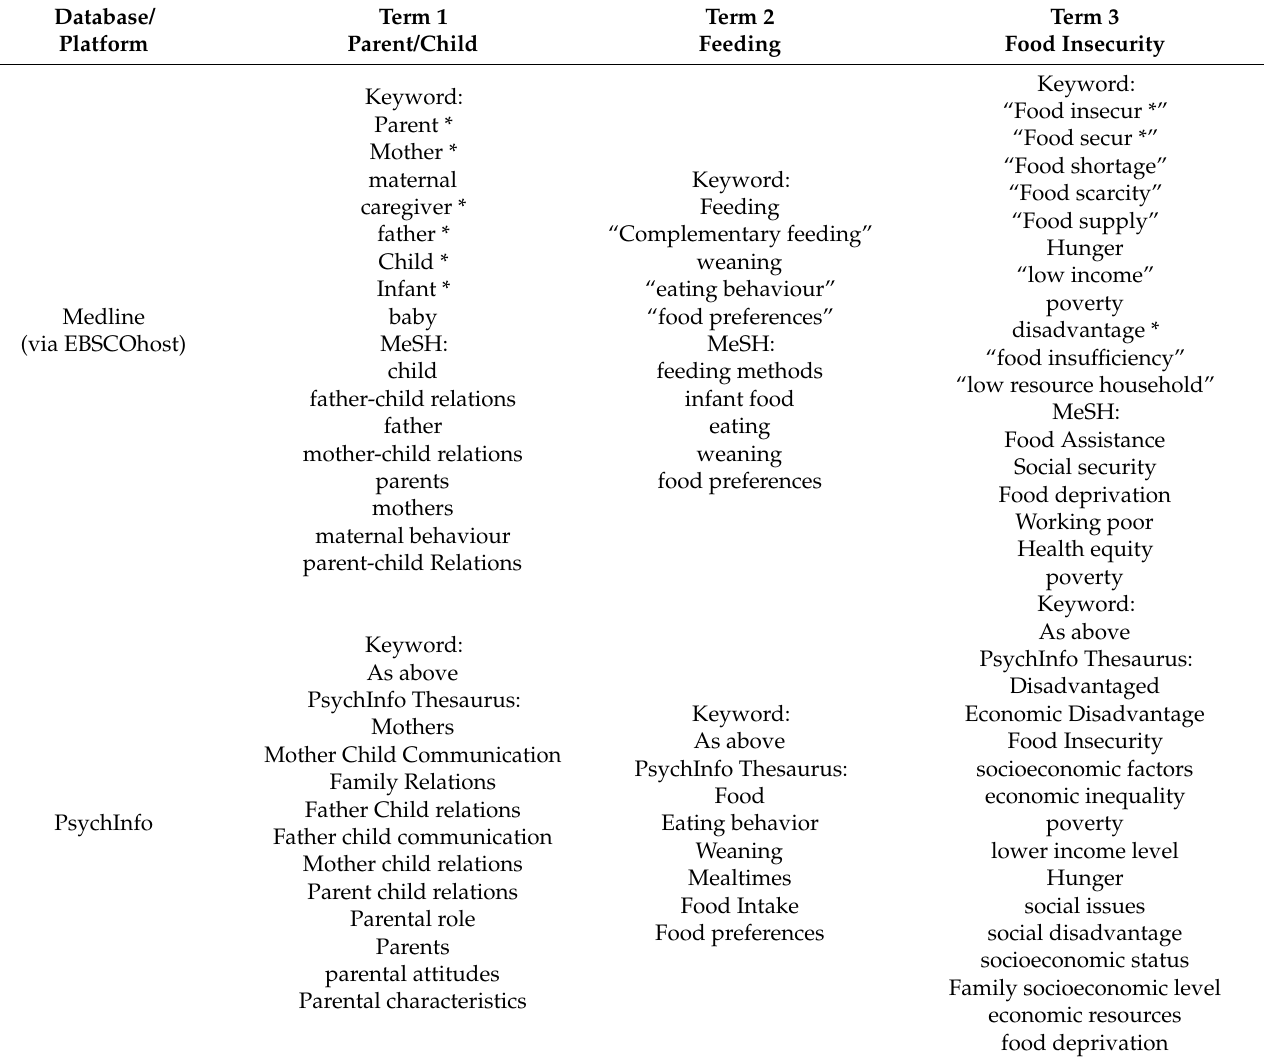
Table A1. Key words for the search strategy used in each